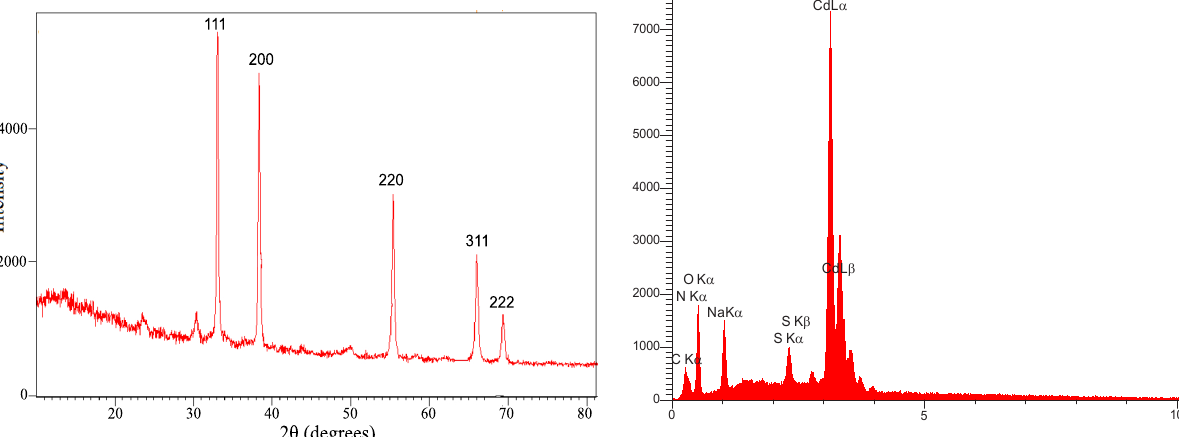
Fig. 4. Energy dispersive analysis of X-RAY (EDAX) for